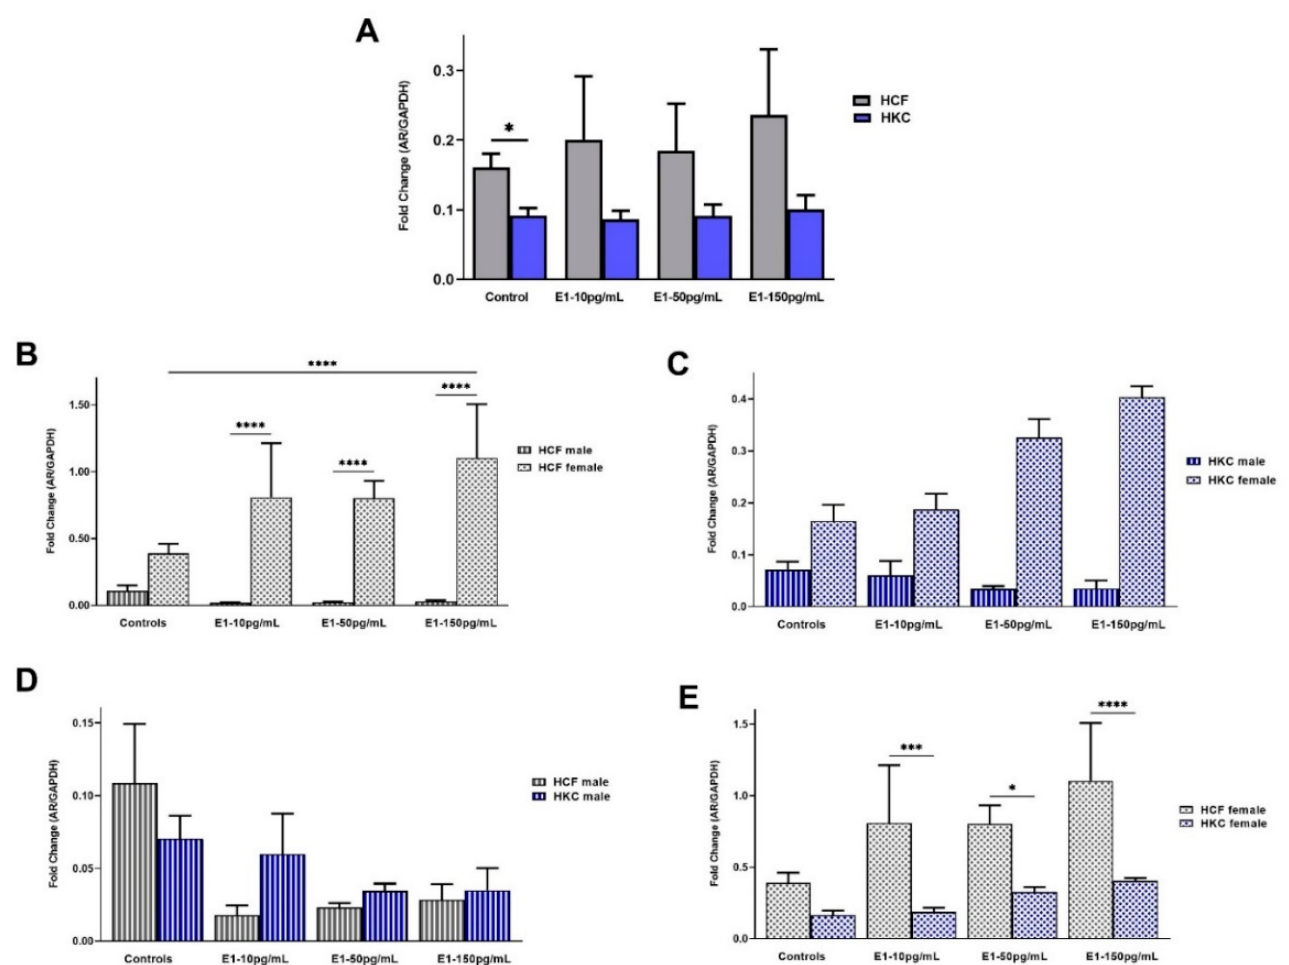
Figure 1. Expression of AR in 3D HCFs and HKCs in response to 10, 50, 150 pg/mL E1 stimulation for four weeks. ( A ) Overall AR expression in HCFs and HKCs ( n = 6). ( B ) Sex-specific expression of AR in HCFs ( n = 3). ( C ) Sex-specific AR expression in HKCs ( n = 3). ( D ) Male-specific AR expression in HCFs vs. HKCs ( n = 3). ( E ) Female-specific expression of AR in HCFs vs. HKCs. ( n = 3). * p < 0.05, *** p < 0.001, and **** p < 0.0001.